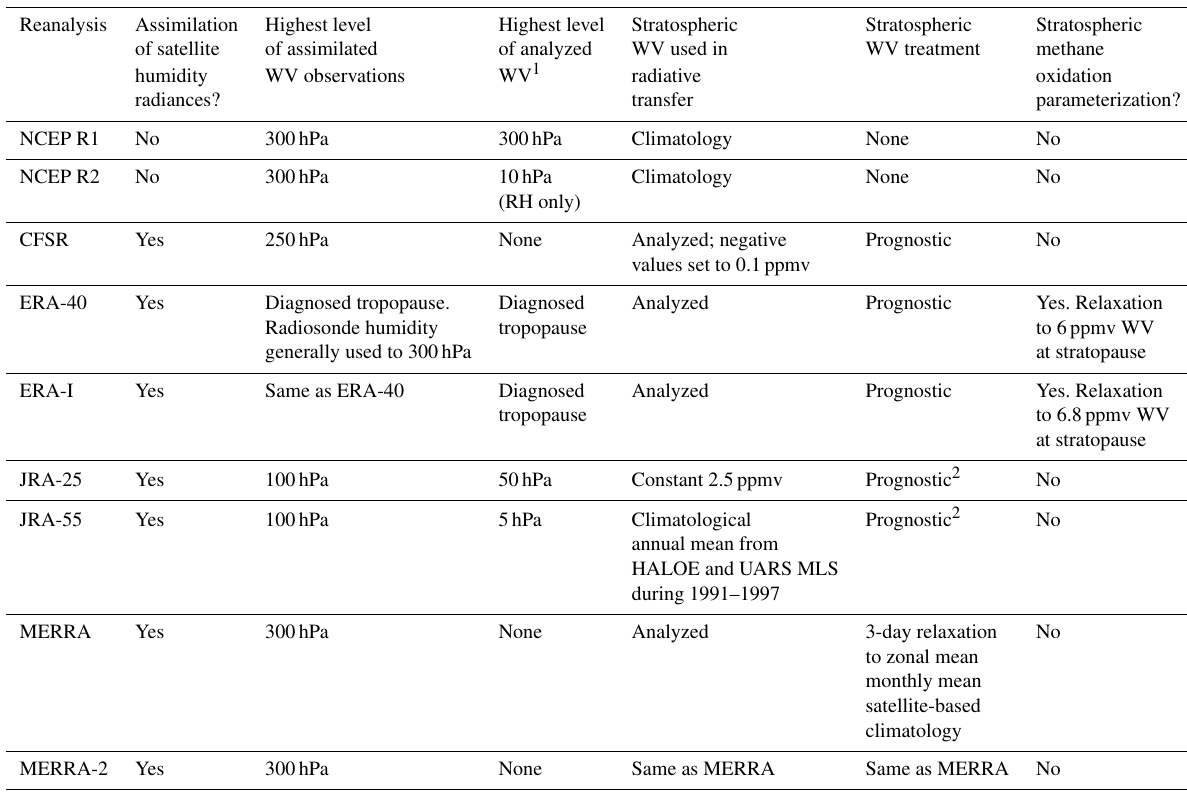
Table 2. Key characteristics of water vapor treatment in